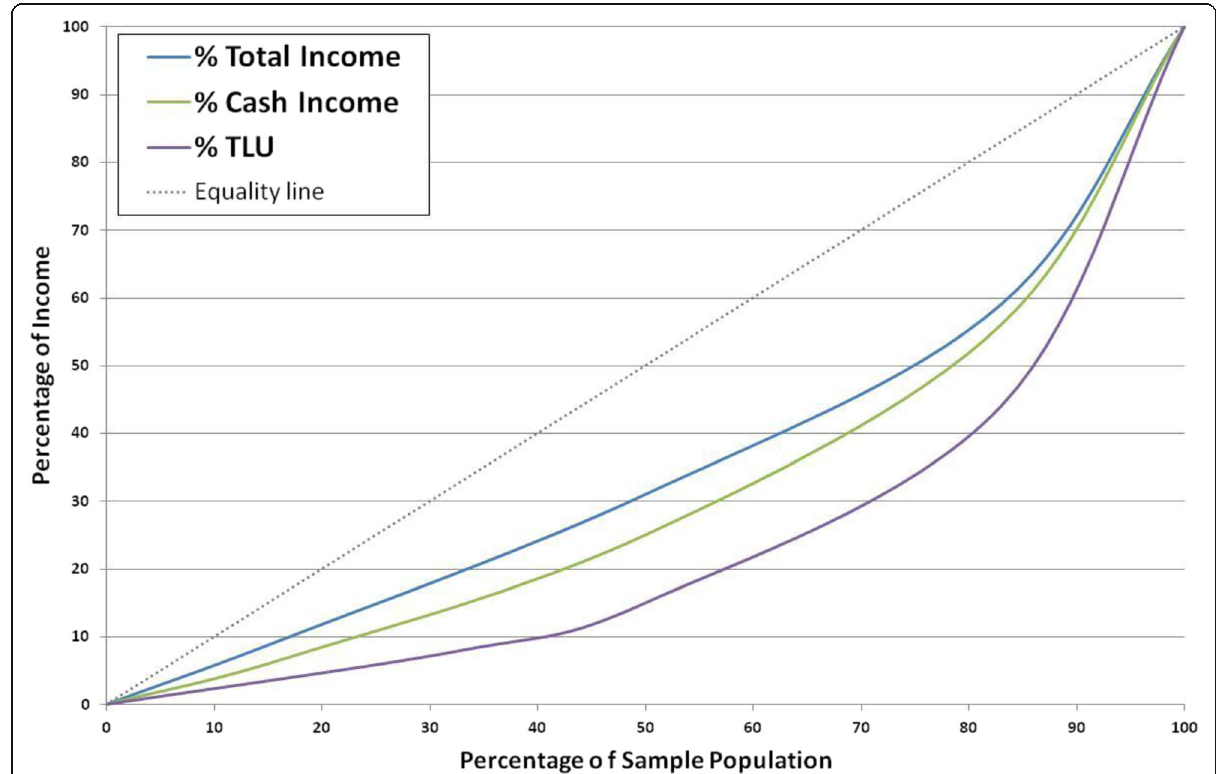
Figure 4 Lorenz curves of the distribution of total income, cash income and